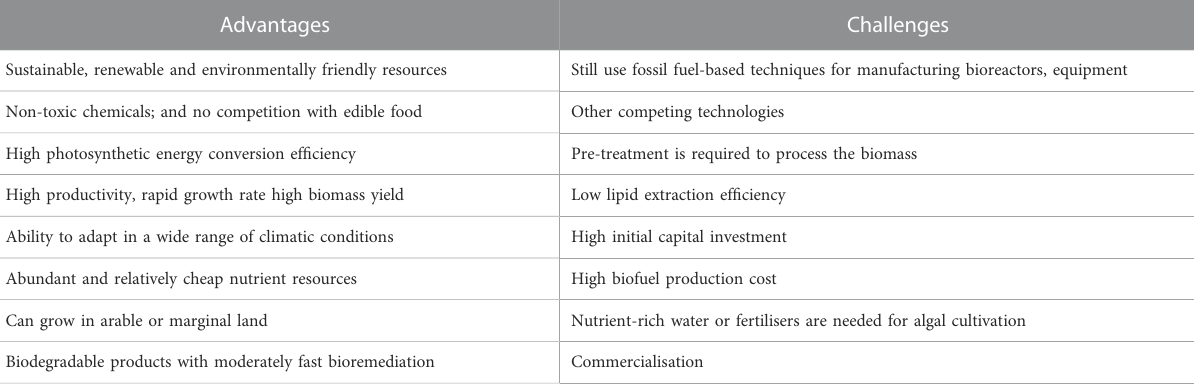
TABLE 1 Advantages and challenges ( at present ) for microalgae-based